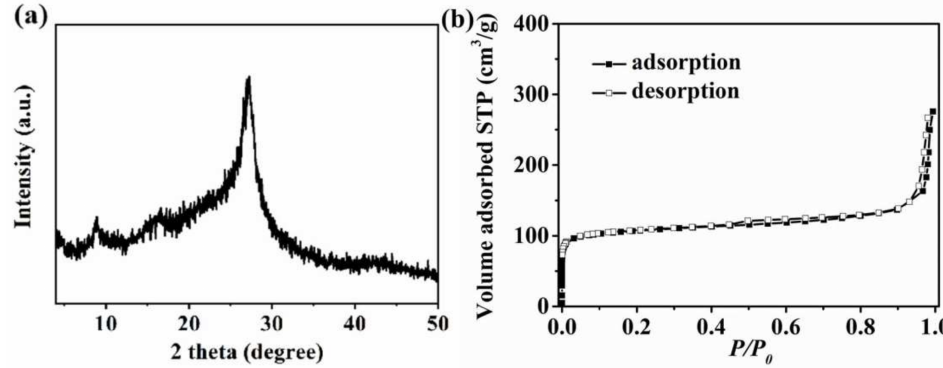
Figure 1. ( a ) XRD of ATG-DMTZ-COF. ( b ) N 2 adsorption of ATG-DMTZ-COF at 77K.